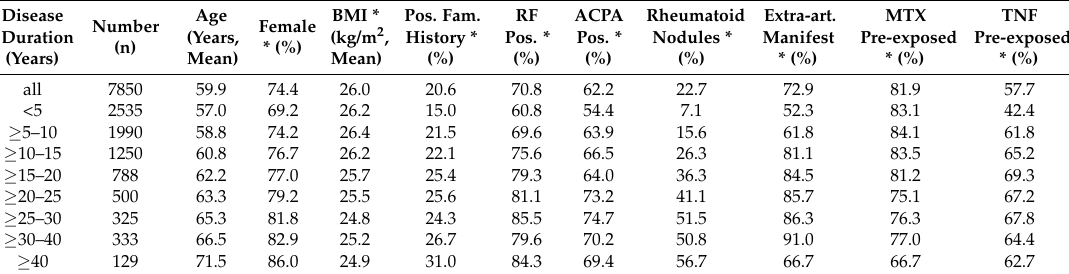
Figure 1. Patient distribution according to disease duration illustrated as individual data (black line) and as a histogram representing the subgroups described in Table 1. Table 1. Patient characteristics.